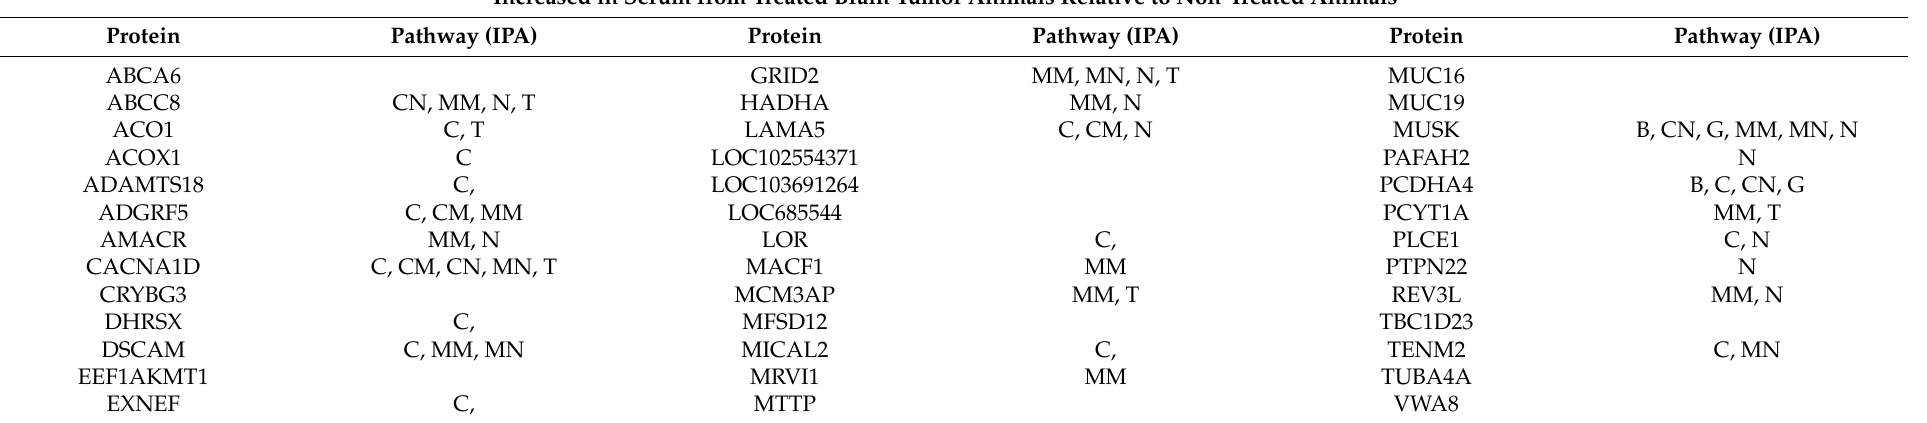
Table 2. Cont . Increased in Serum from Treated Brain Tumor Animals Relative to Non-Treated